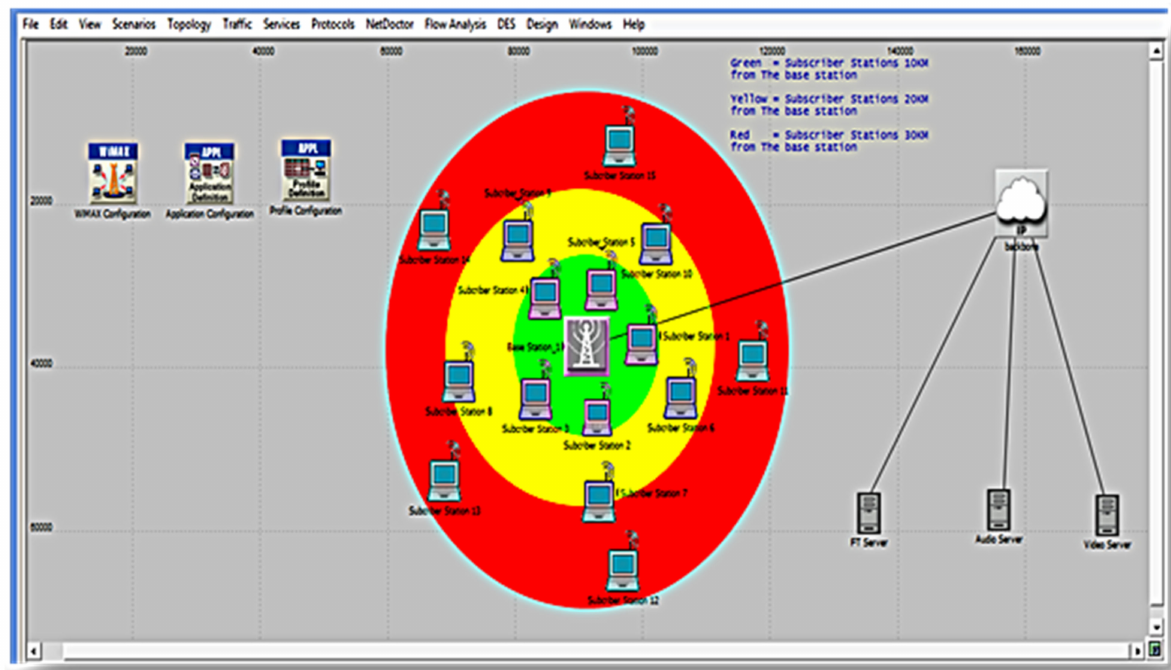
Figure 2. Simulation